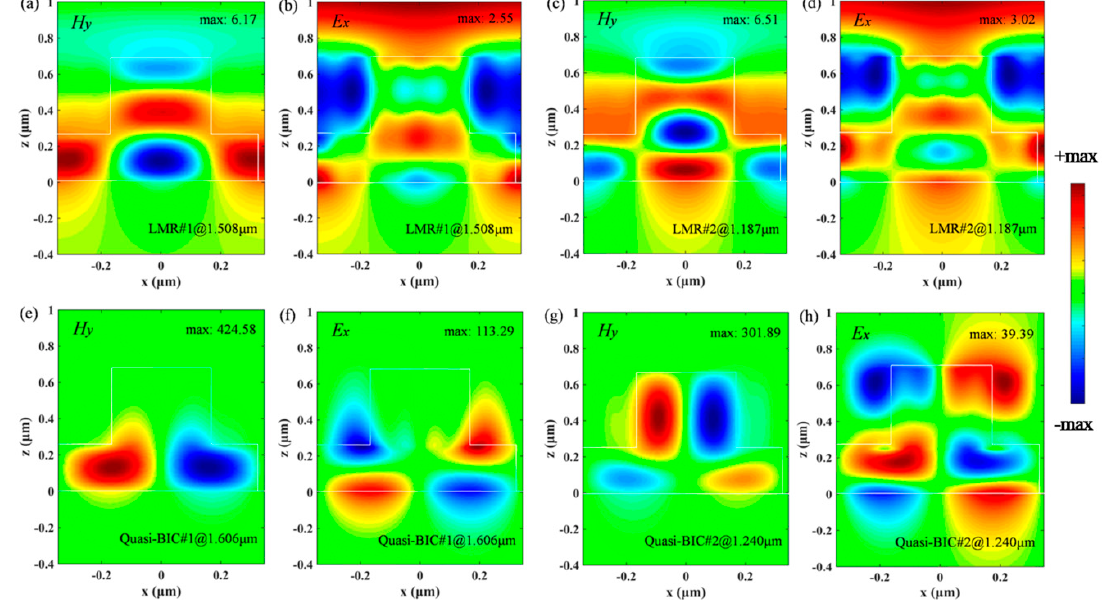
Figure 4. Distributions of electromagnetic fields associated with the leaky mode resonances (LMRs) and quasi-bound states in the continuum (BICs) of the Si-based PCS without graphene as s = 10 nm. Other parameters are the same as those in Figure 2. H y and E x denote the tangential components of the magnetic and electric field amplitudes, respectively, the values are normalized by incident field amplitudes. ( a ) H y and ( b ) E x of the LMR#1. ( c ) H y and ( d ) E x of the LMR#2. ( e ) H y and ( f ) E x of the quasi-BIC#1. ( g ) H y and ( h ) E x of the quasi-BIC#2.